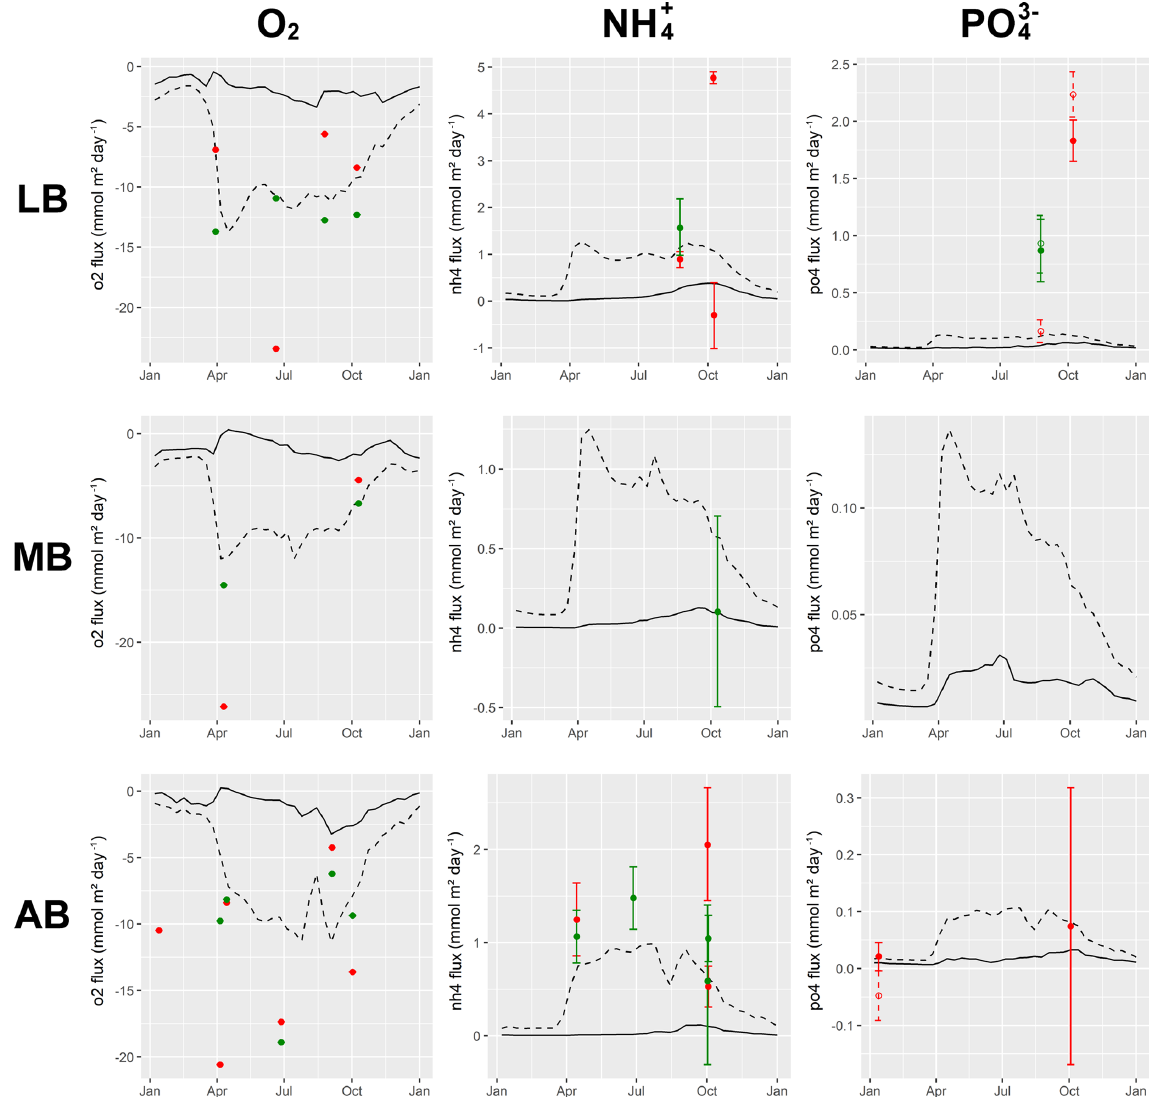
Figure 9. Fluxes between the sediment and bottom water of selected pore water species at mud stations. Positive values denote fluxes out of the sediment. Solid line: modelled fluxes between sediment and bottom water only. Dashed line: fluxes including mineralisation of the fluff layer material. Dots: measured fluxes by two benthic chambers (BC1 in red and BC2 in green). Vertical ranges: uncertainties of these fluxes estimated by a bootstrapping method. For phosphate: full circles are estimates based on phosphate determination by photometric methods, and open circles are estimates based on P quantification by the ICP-OES